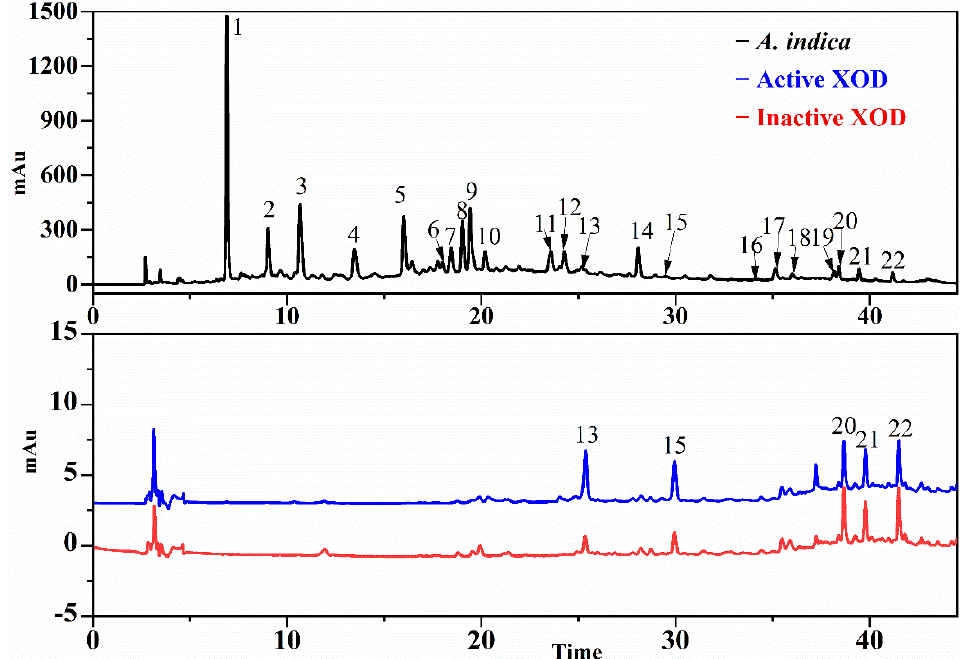
Figure 4. The UF-LC-UV chromatograms of EA fraction from A. indica xanthine oxidase (XOD) at 280 nm. The black line represents HPLC profiles of EA fraction, the blue and red lines represent activated and inactivated XOD,